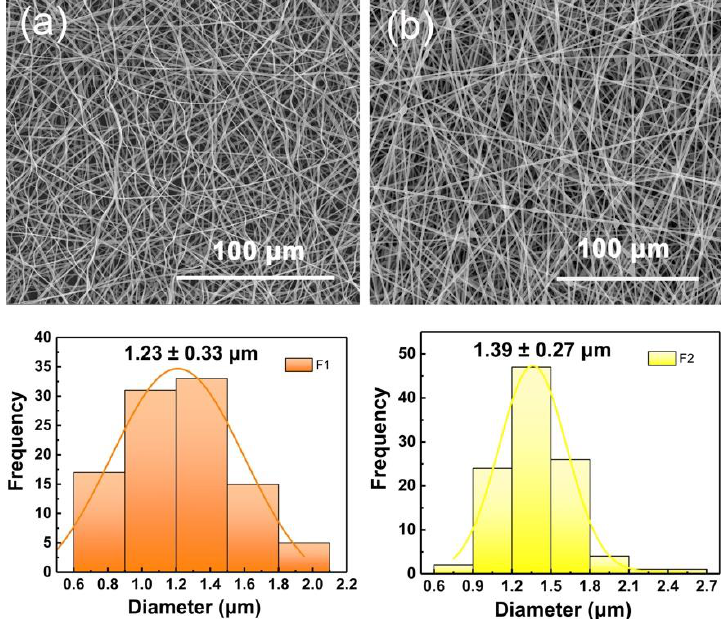
Figure 2. SEM images of ( a ) F1 and ( b ) F2 fibers. The average fiber diameter is distributed directly below the corresponding SEM image.